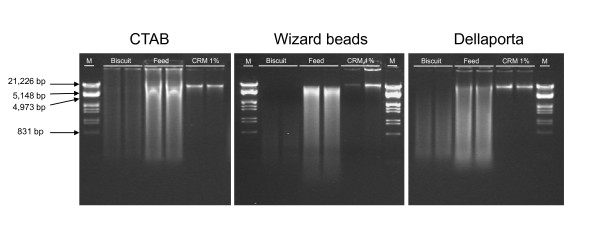
Agarose-gel electrophoresis of DNA extracts by matrix and DNA extraction method. M, λ DNA/EcoRI + HindIII.